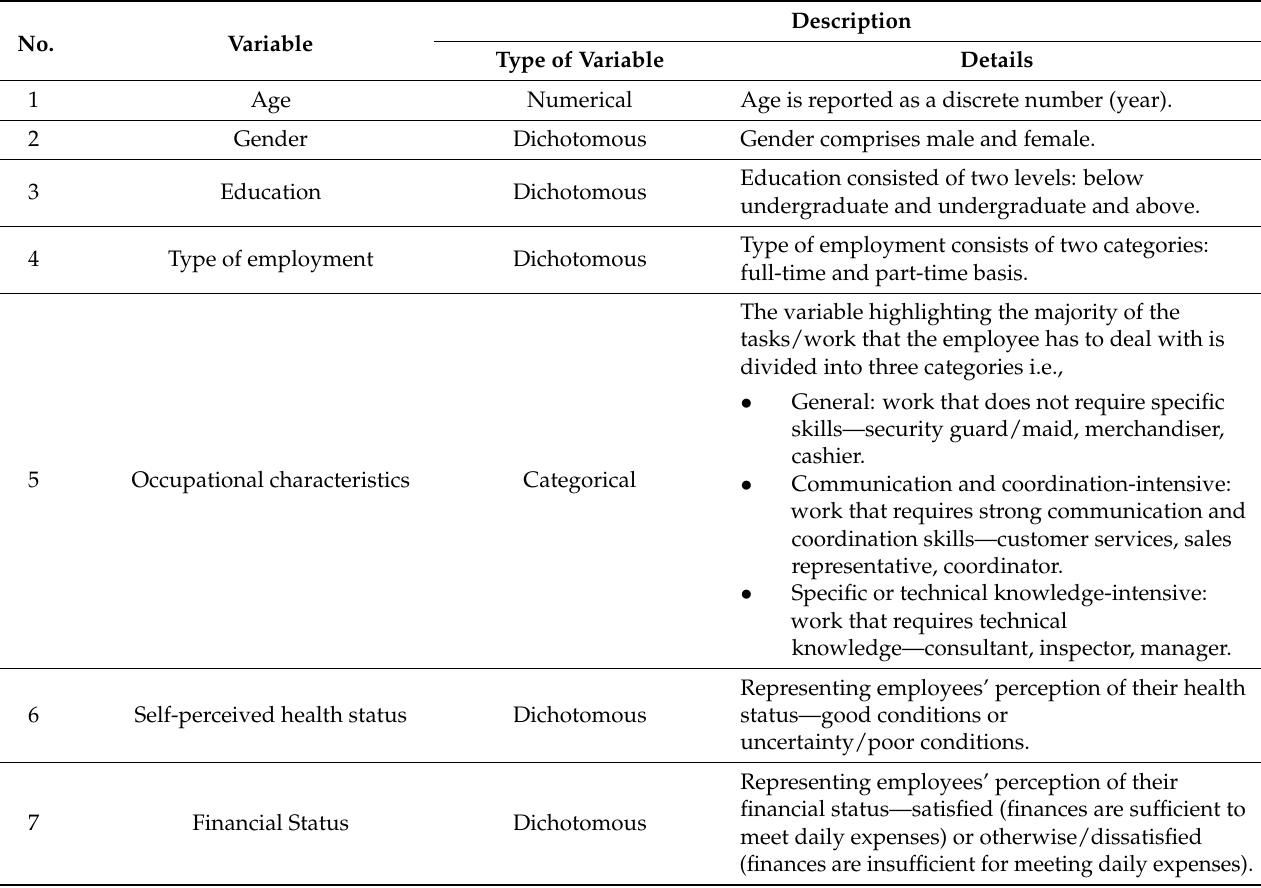
Table 1. Description of factors determining